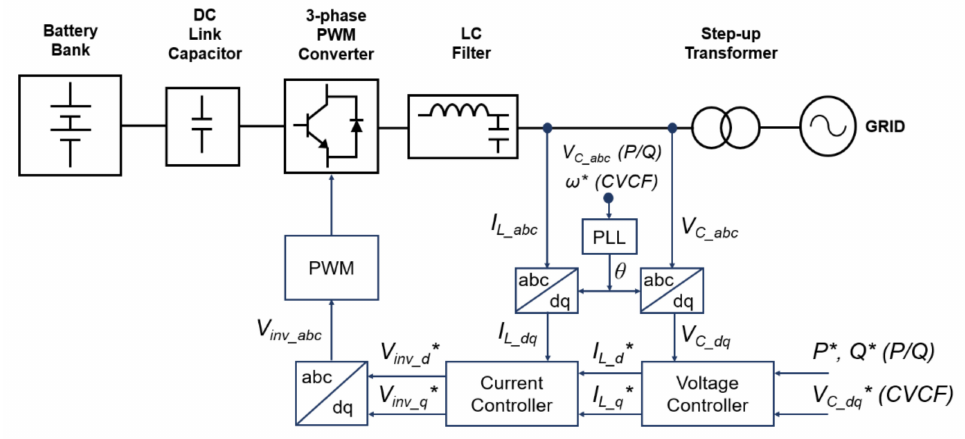
Figure 6. Simplified block diagram and control of energy storage systems